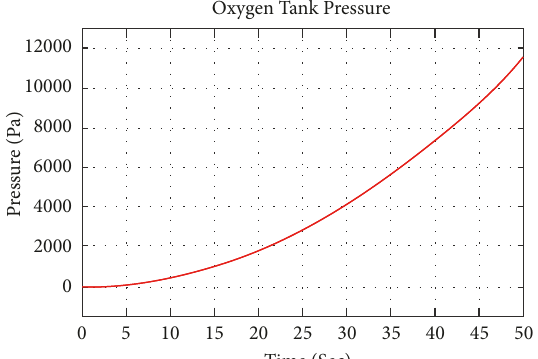
Figure 16: The pressure of compressed oxygen tank.